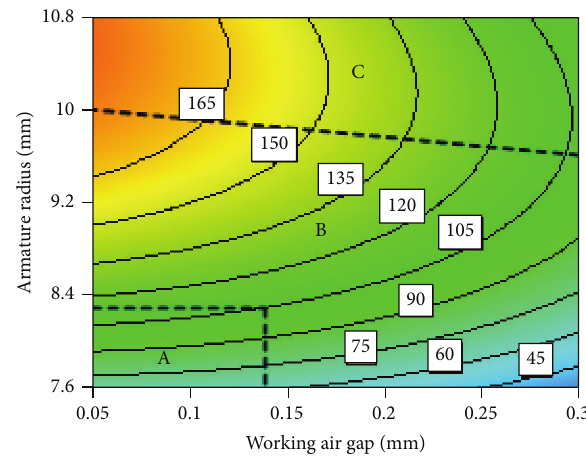
Figure 17: Interaction of working air gap and armature